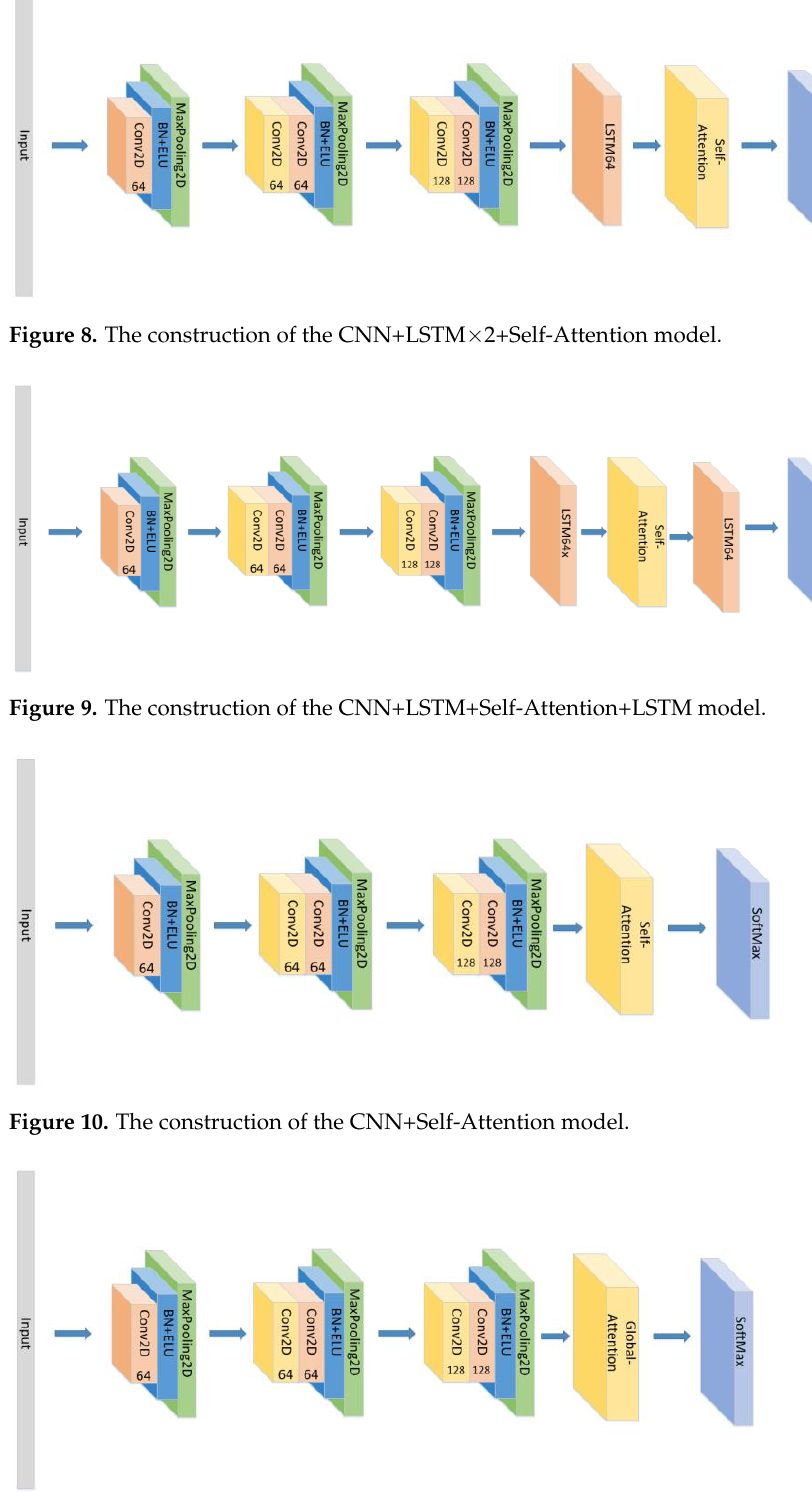
Figure 7. The construction of the CNN+LSTM+Global-Attention+LSTM model. (4) Change the form of the attention mechanism as seen in Figure 8 and set the CNN+ LSTM × 2+Self-Attention network with the same parameters as the original model to explore the influence of the form of attention on the accuracy of the model.